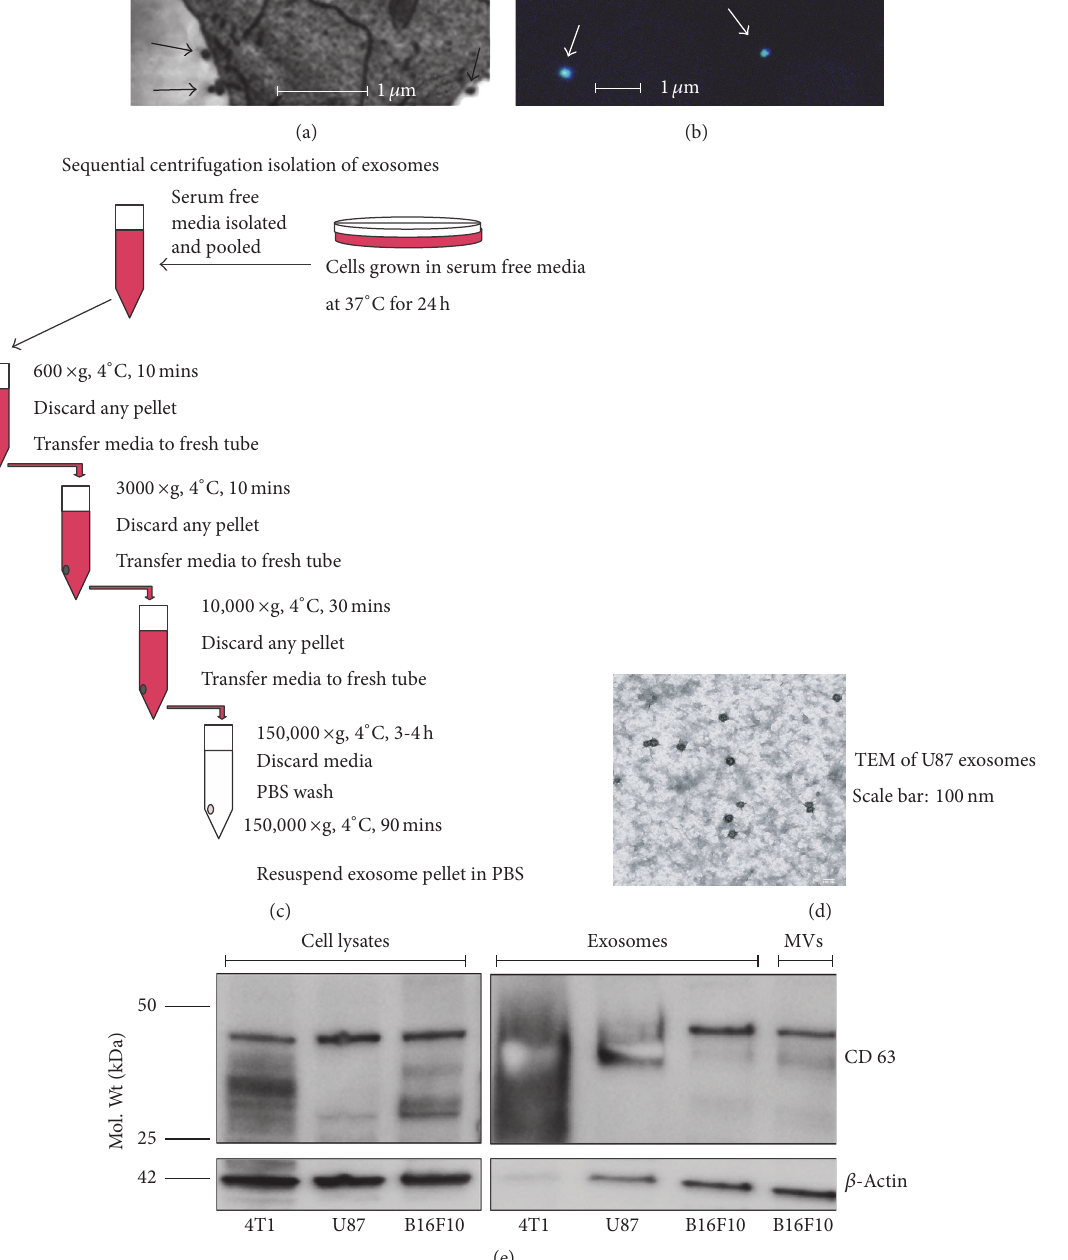
targets like CTPs (acoustic confinement [34]) and by the use of an optimized acoustic detection